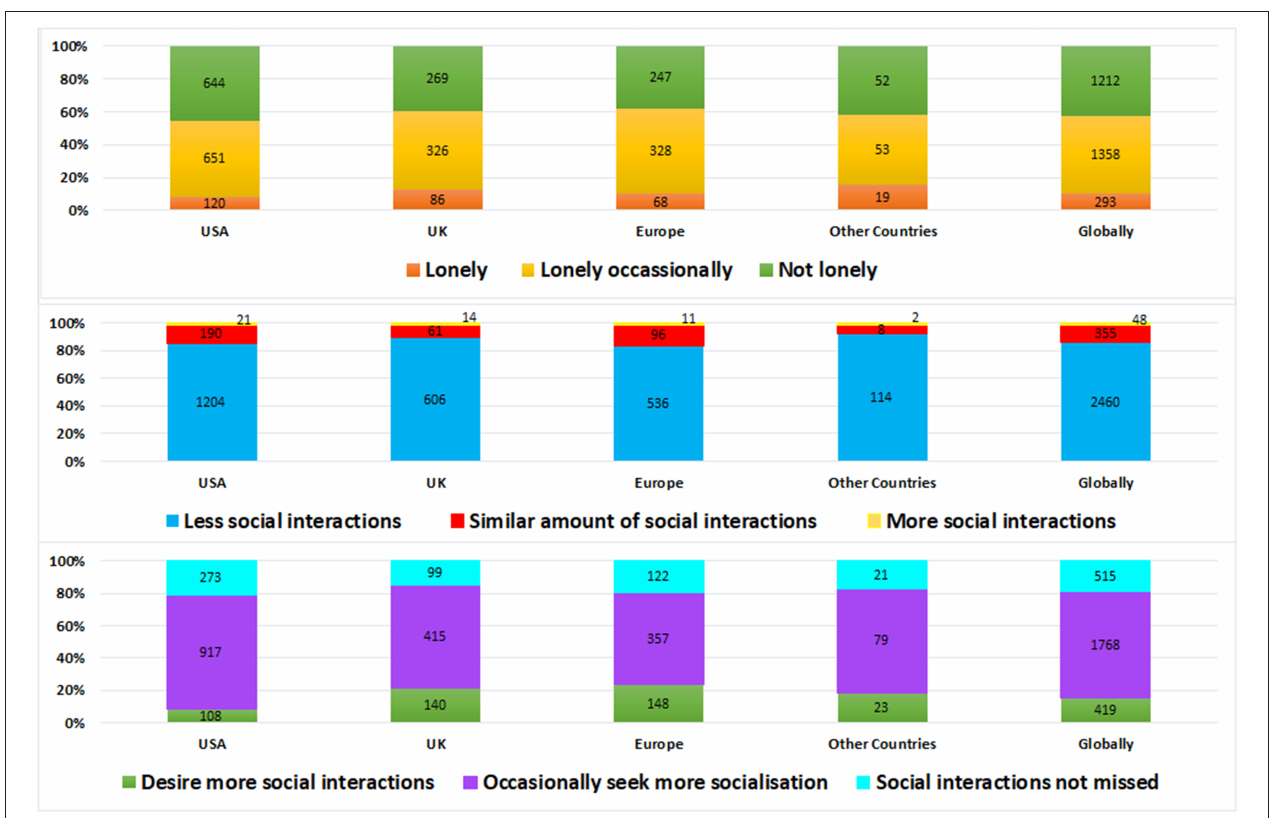
FIGURE 5 | The frequency of social interactions, desire for more interactions and loneliness experienced during the pandemic across different locations.